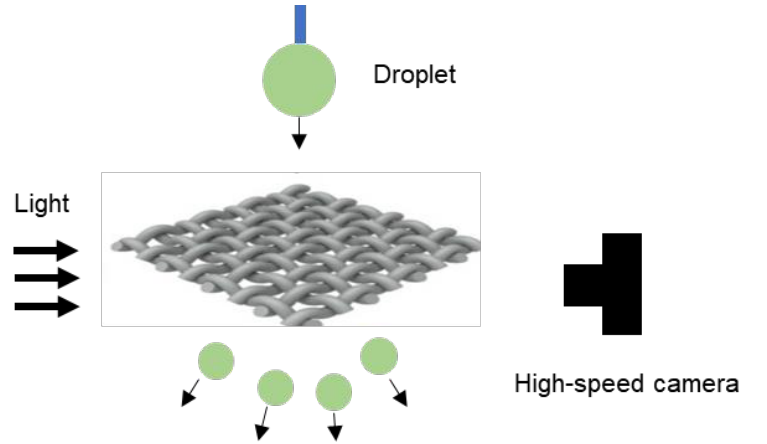
Figure 3. Schematic of the experimental setup to test the stability of water on